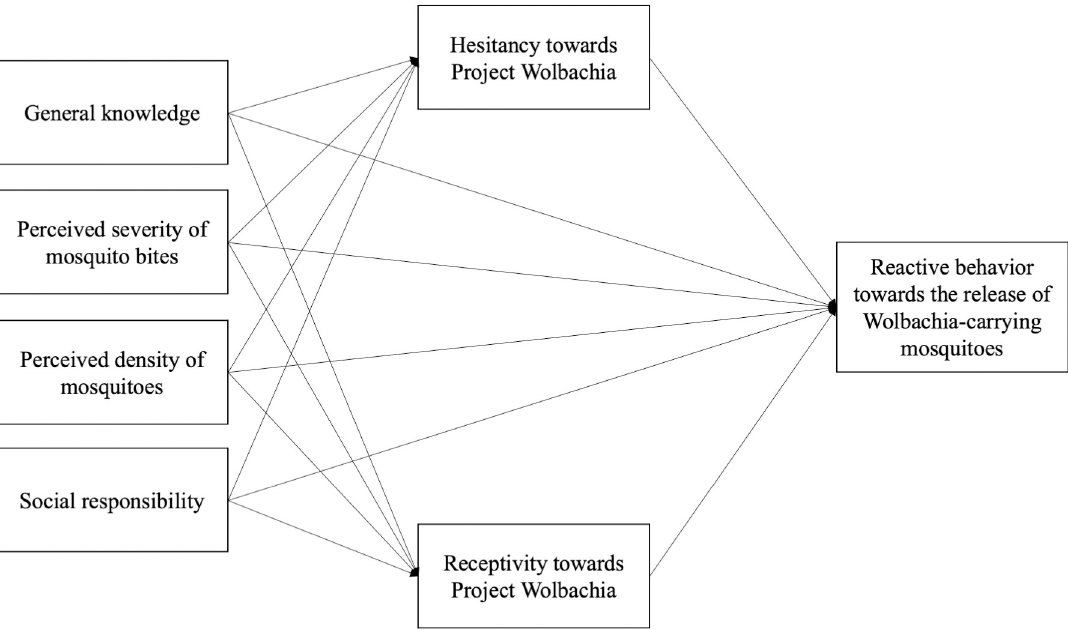
Fig 1. Proposed conceptual model: Public Wolbachia Response